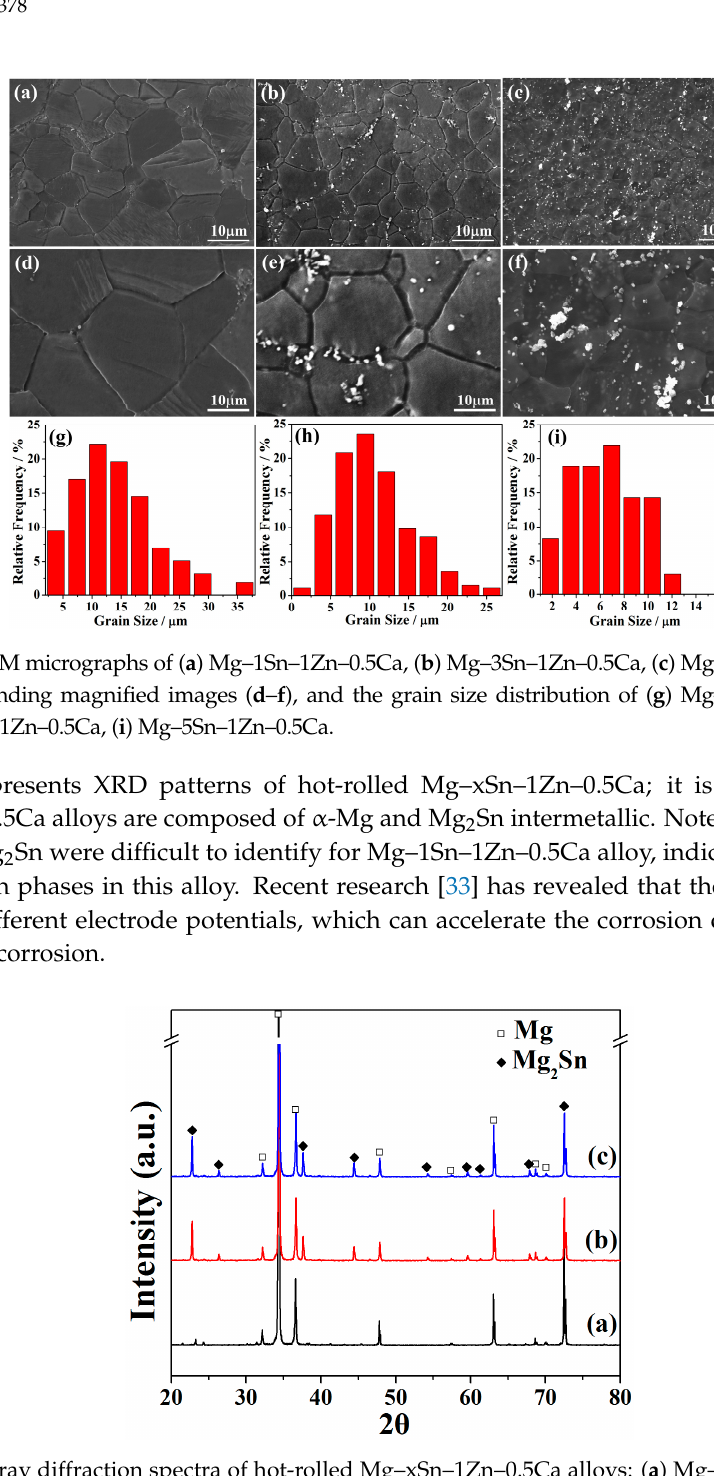
Figure 2. X-ray diffraction spectra of hot-rolled Mg − xSn − 1Zn − 0.5Ca alloys: ( a ) Mg − 1Sn − 1Zn − 0.5Ca; ( b ) Mg − 3Sn − 1Zn − 0.5Ca; ( c ) Mg − 5Sn − 1Zn − 0.5Ca.